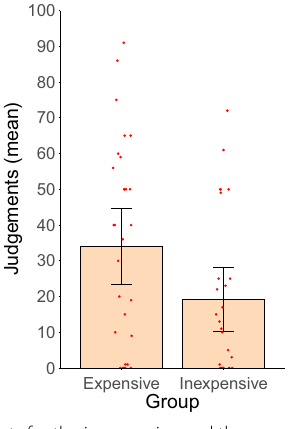
Fig. 2 Judgements for the inexpensive and the expensive drug. Note. Bars represent the mean judgements for each group. Error bars depict the 95% confidence intervals for the means. Dots indicate the individual data of each